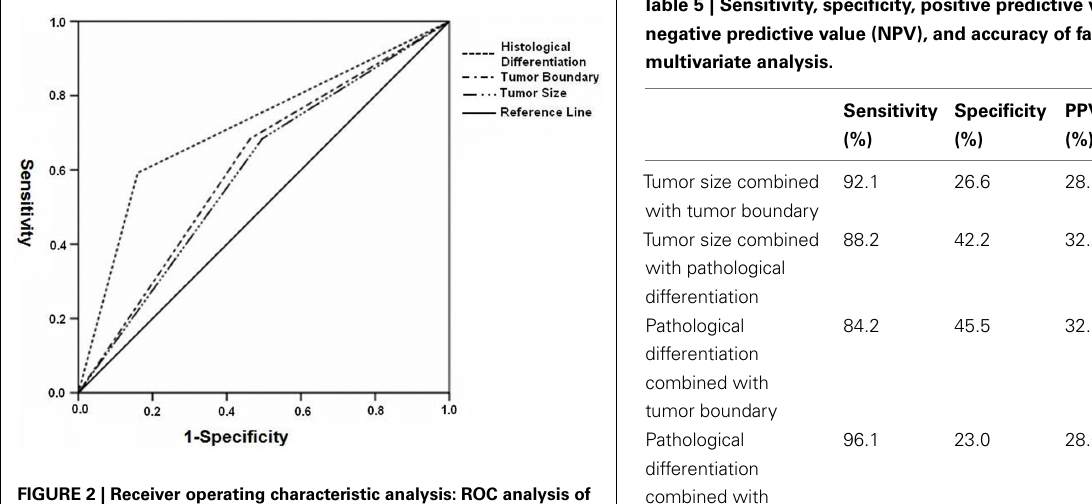
FIGURE 2 | Receiver operating characteristic analysis: ROC analysis of histological differentiation, tumor boundary, and tumor size. The AUC of all parameters was less than 0.5, indicating that they were predictive of LNM.